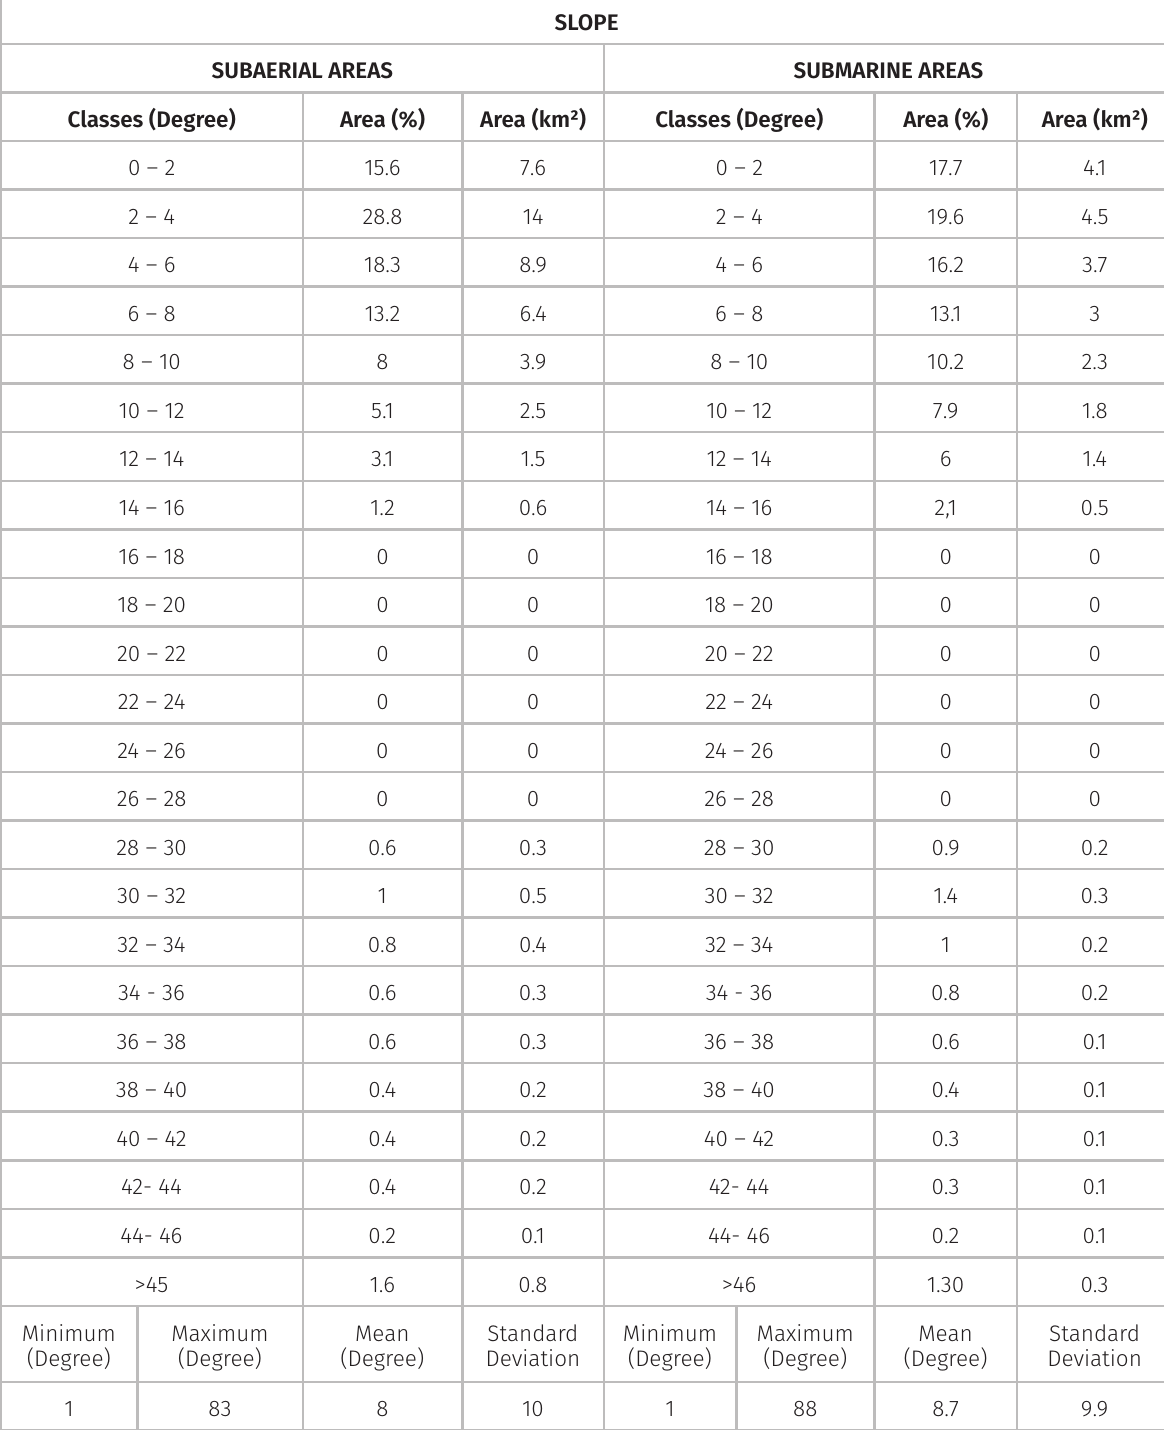
Table III. Absolute and relative areas, statistics of the slope classes at each sector. SLOPE SUBAERIAL AREAS SUBMARINE